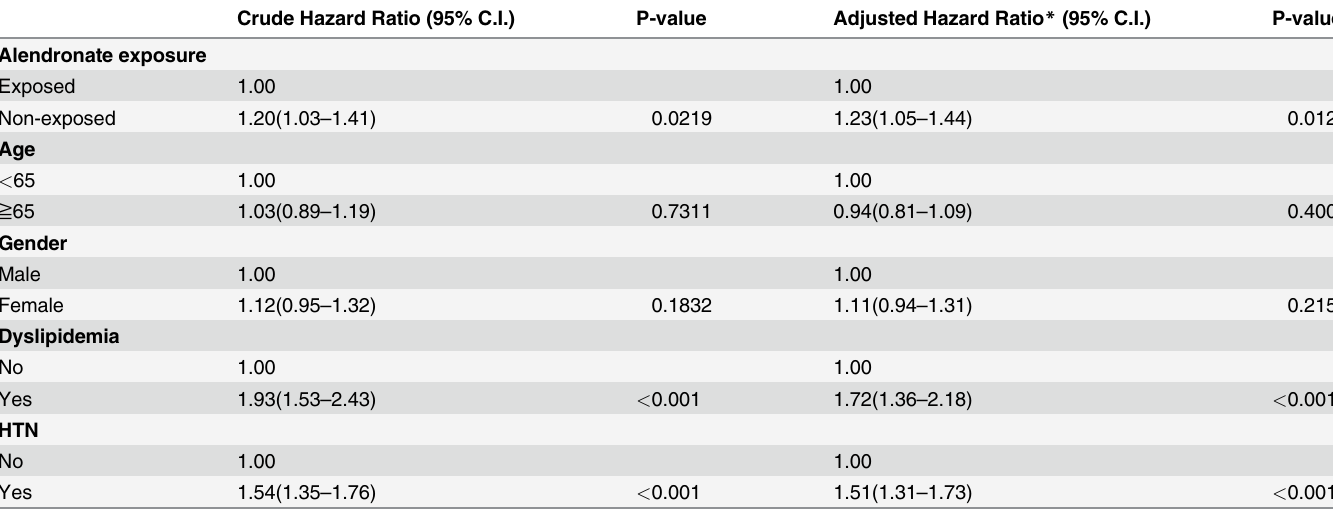
Table 3. Hazard Ratio for new onset type 2 DM (both group, N = 4044).